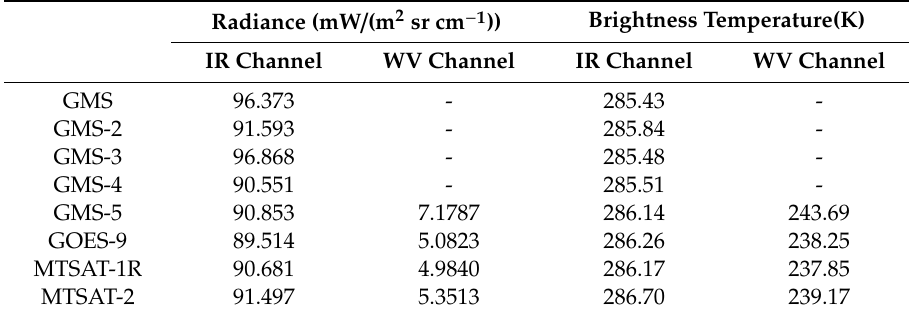
Table 5. Standard radiances and brightness temperatures for JMA’s GEO